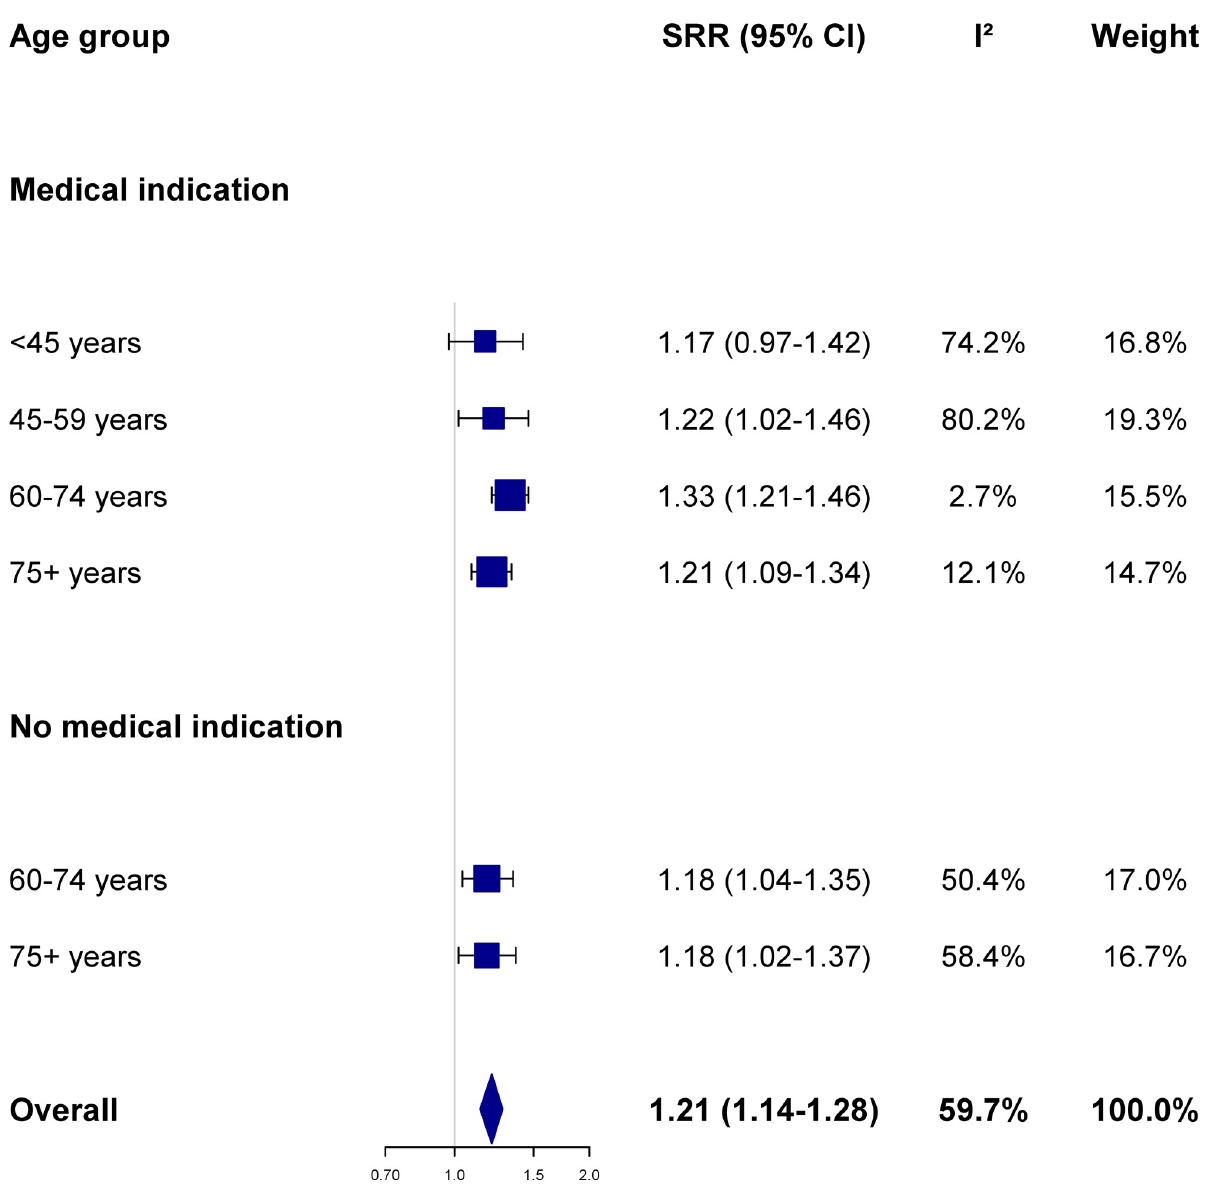
Fig 4. Association between influenza vaccination and the risk of lower back pain according to age group and presence of medical indication. Summary risk ratio (SRR) and 95% confidence intervals (CI) were calculated by pooling season-specific risk ratio using random effects meta-analysis models; between-seasons heterogeneity was quantified using the I 2 statistics (see text for details; season-specific risk ratio were provided in S4 Table). The Netherlands, seasons 2006/07 to 2015/16.